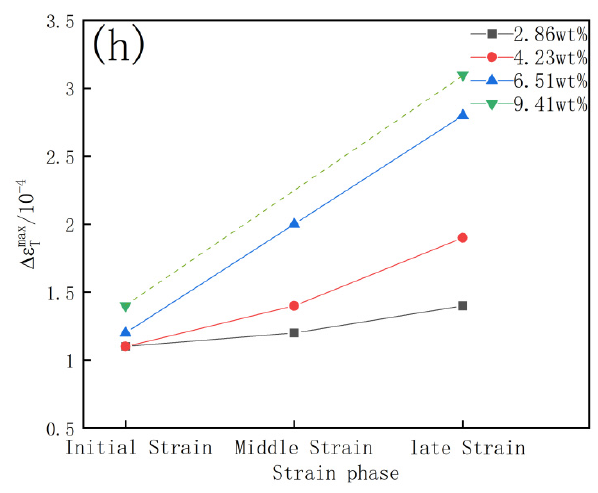
Figure 5. Stress–strain curve of quenched Al-(2.86~9.41) Mg alloy sheet at room temperature at 1 × 10 − 3 s − 1 strain rate ( a ) Stress–strain curve; ( b – d ) are subgraphs of ( a ). ( e ) Enlarged view of initial plastic deformation; ( f ) Enlarged view of initial plastic deformation. ( g ) Enlarged view of the initial plastic deformation; ( h ) Change curve of ∆ ε max with different Mg contents during the plastic deformation stage.